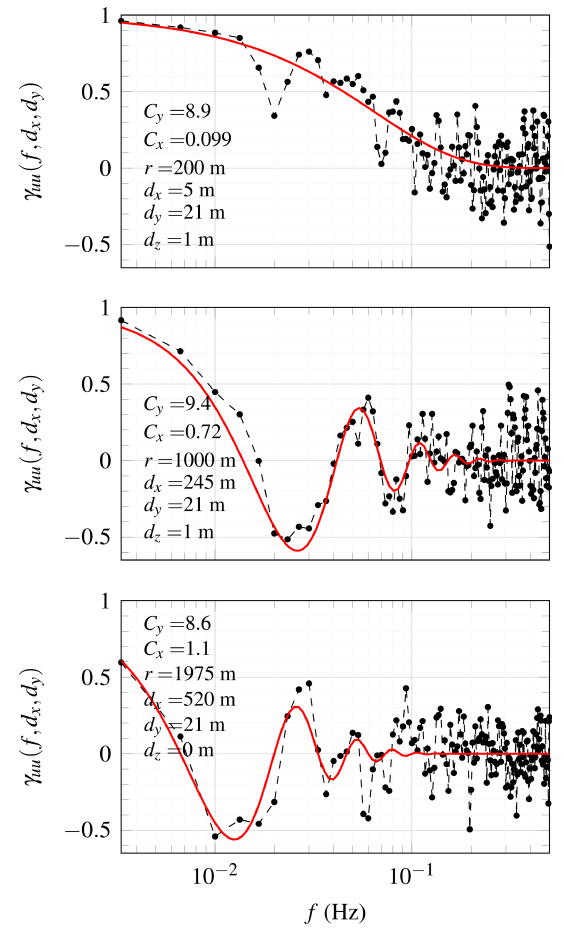
Figure 18. Estimated (scatter) and fitted (solid line) co-coherence of the along-wind component between LidarW and LidarN using range gates at 500, 1000 and 1975m from LidarW. The time series selected is displayed in Fig. 13 and corresponds to an original az- imuth of 225 ◦ and an elevation of 4 . 9 ◦ , which were then corrected for possible offsets as described in Sect.